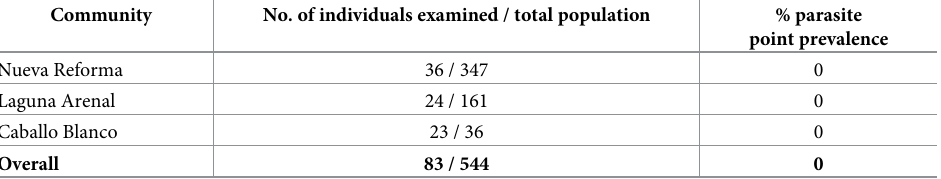
Table 3. Parasite prevalence (skin mf by microscopy and O-150 PCR-ELISA) in three communities of the for- merly Southern Chiapas focus, Mexico.